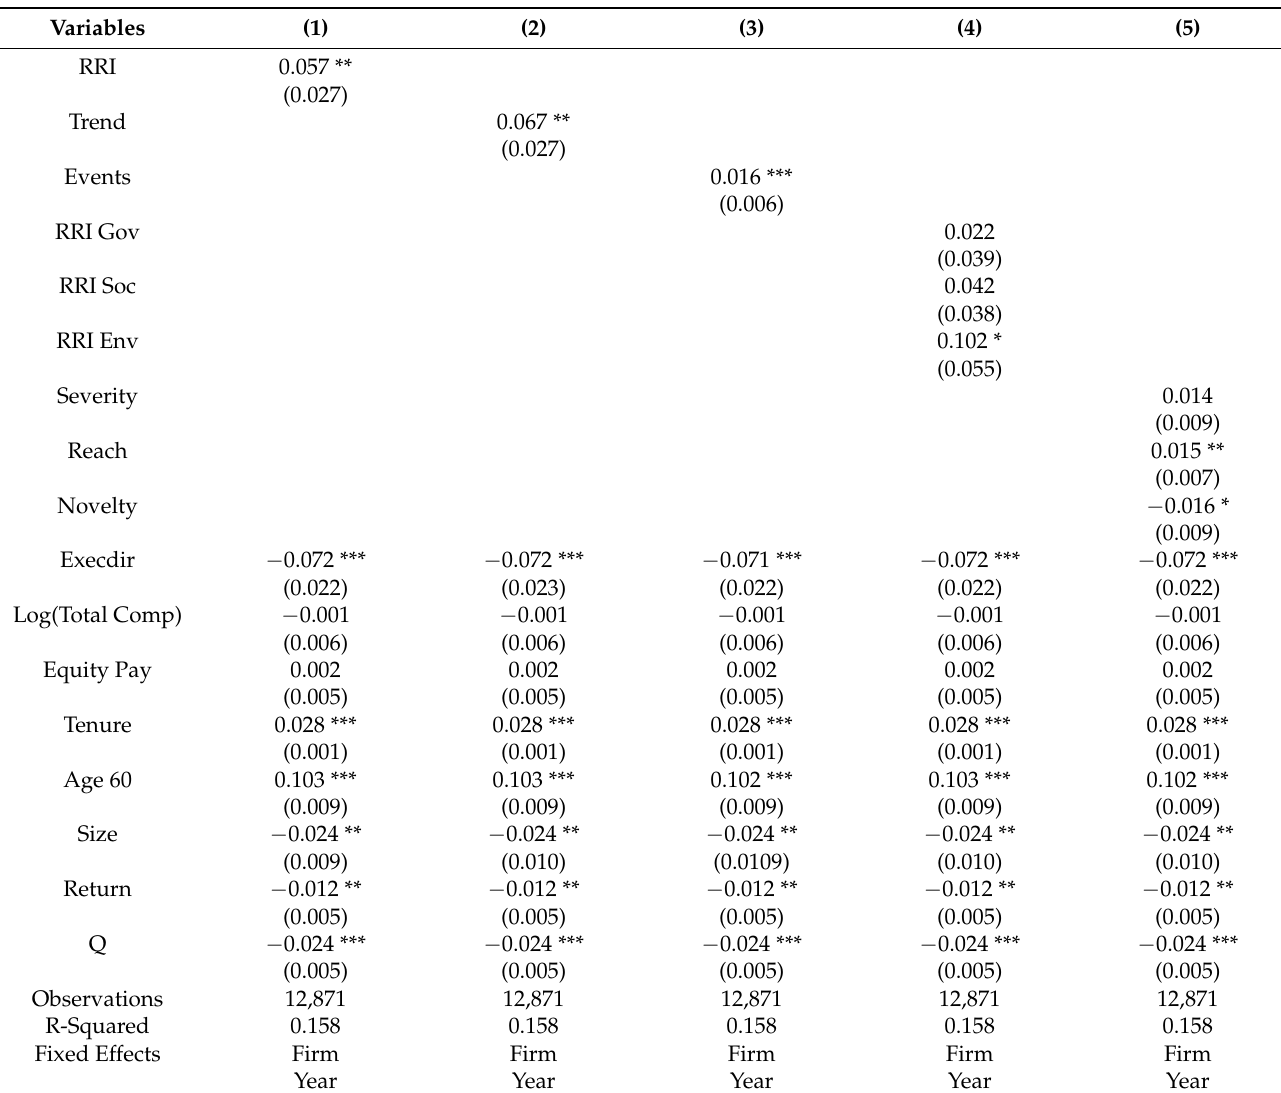
Table 5. Robustness. The dependent variable is CEO turnover. See Appendix A for variable definitions. Standard errors are clustered by firm and reported in parentheses. *, ** and *** represent statistical significance at the 10%, 5% and 1% level,